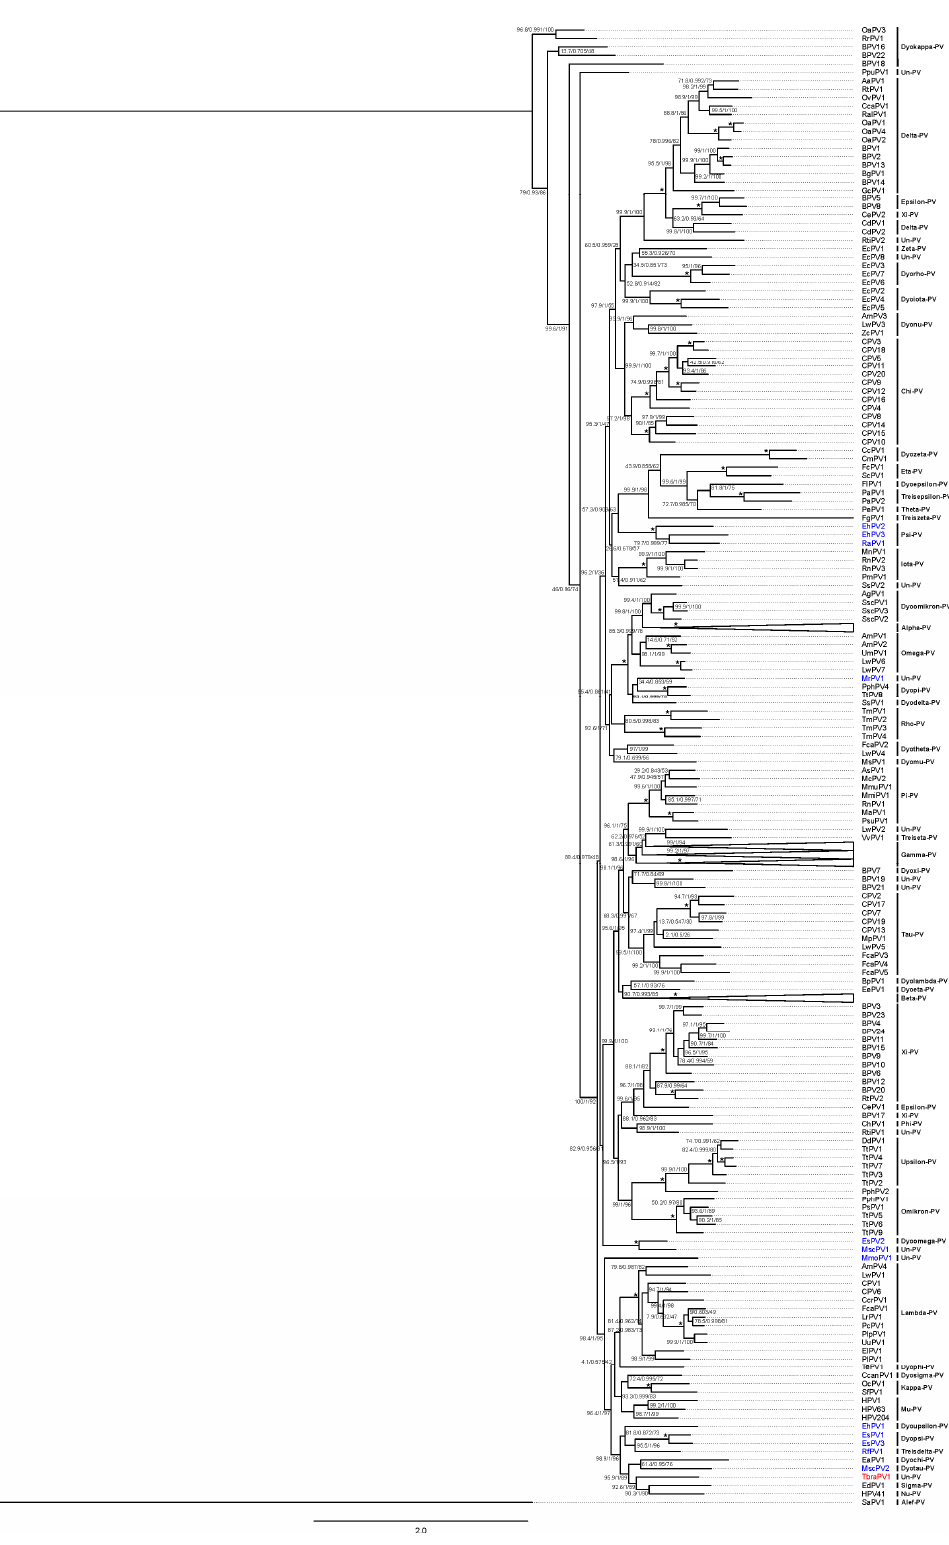
Figure 4. Phylogenetic tree of the PV L1 gene. The tree was constructed using the GTR + F + R10 model, and branches are annotated with SH-aLRT (1000 replicates), aBayes, and UF bootstrap support (1000 replicates) values, respectively. Maximum support values are shown with asterisks (*). Alpha -, Beta -, and Gamma -PV genera were collapsed. Novel TbraPV1 is depicted in red. Bat PV types are depicted in blue. Un-PV: unclassified PV